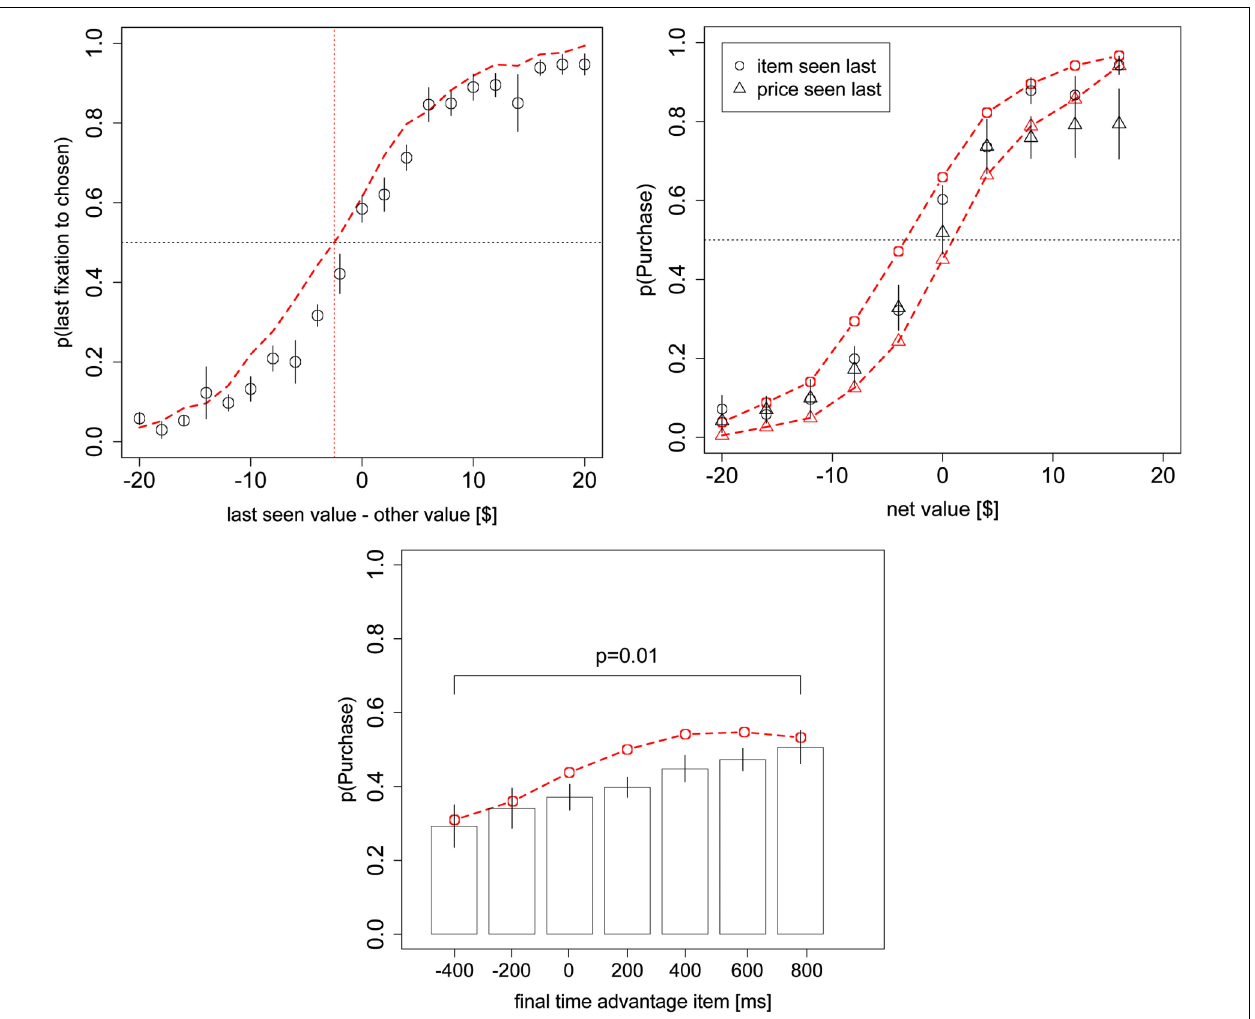
FIGUREA4 | Replication of Figures3A,B, and 4A but using both the even and odd-numbered trials.